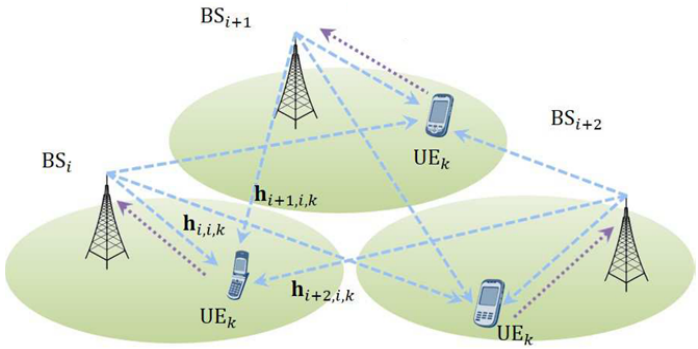
Figure 2. Explanation of inter ‐ cell interference due to pilot contamination at downlink transmission.